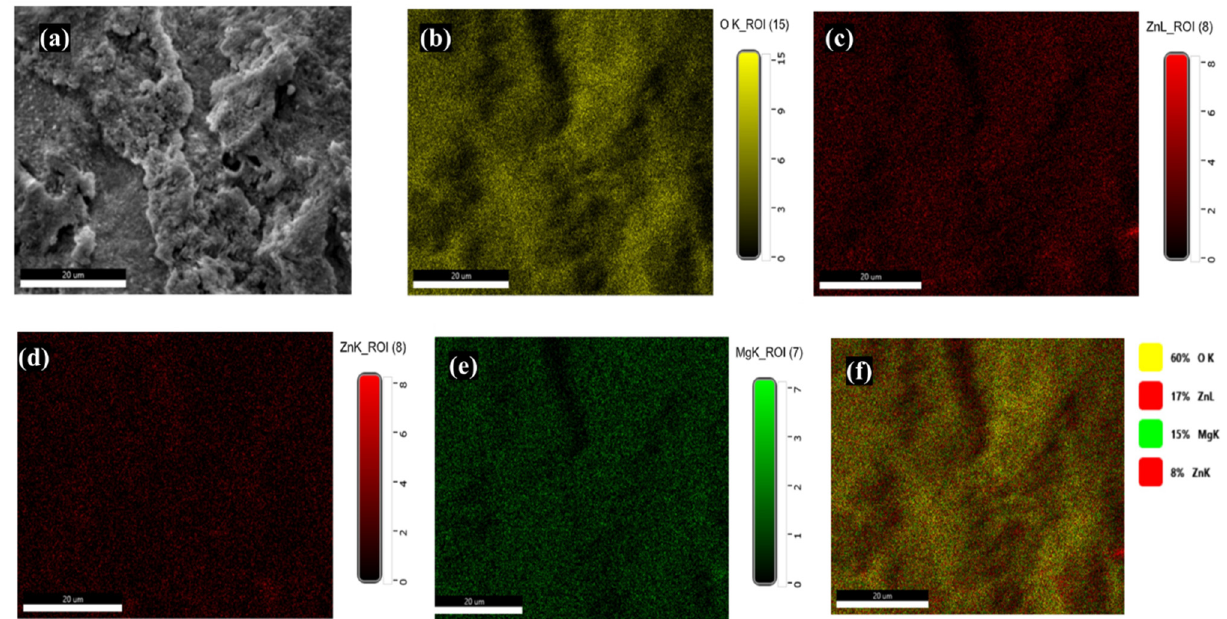
Figure 3. Elemental mapping to confirm the uniform distribution of Mg-doped ZnO NPs in composite (2.5%) at 200 µ m ( a ), surface morphology of reinforced composite, ( b ) distribution of Oxygen in reinforced composite, ( c , d ) distribution of Zinc in reinforced composite, ( e ) distribution of Magnesium in reinforced composite, and ( f ) overlapped distribution of O, Zn, and Mg.